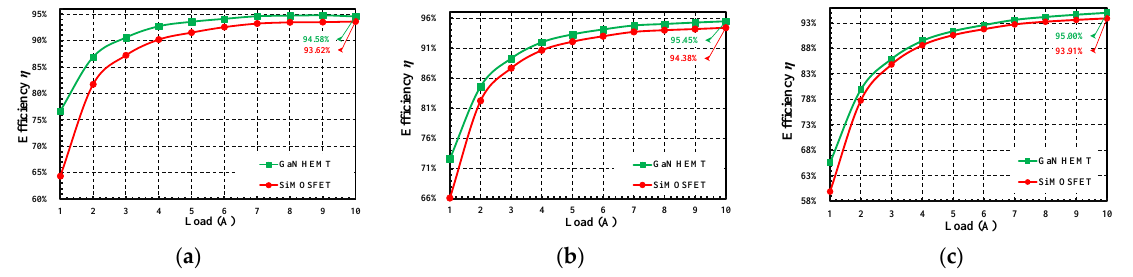
Figure 12. Measured efficiency with different output current at different input voltage: ( a ) V in = 18 V; ( b ) V in = 28 V; ( c ) V in = 36 V.